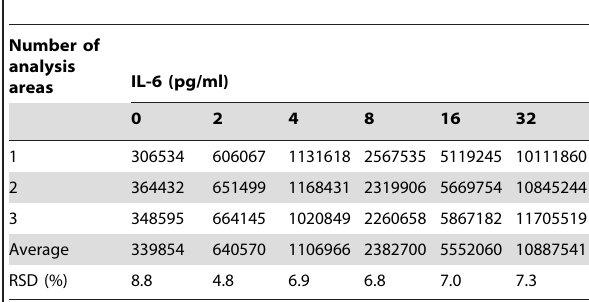
Table 1. Reproducibility of luminescence intensity of IL-6 in 1